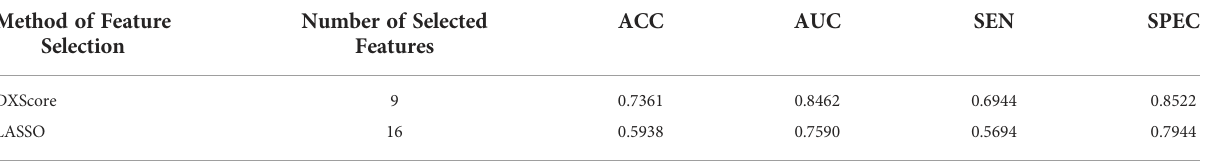
TABLE 2 SVM classi fi cation performance of selected feature subsets with different methods in the test group. . Method of Feature Selection